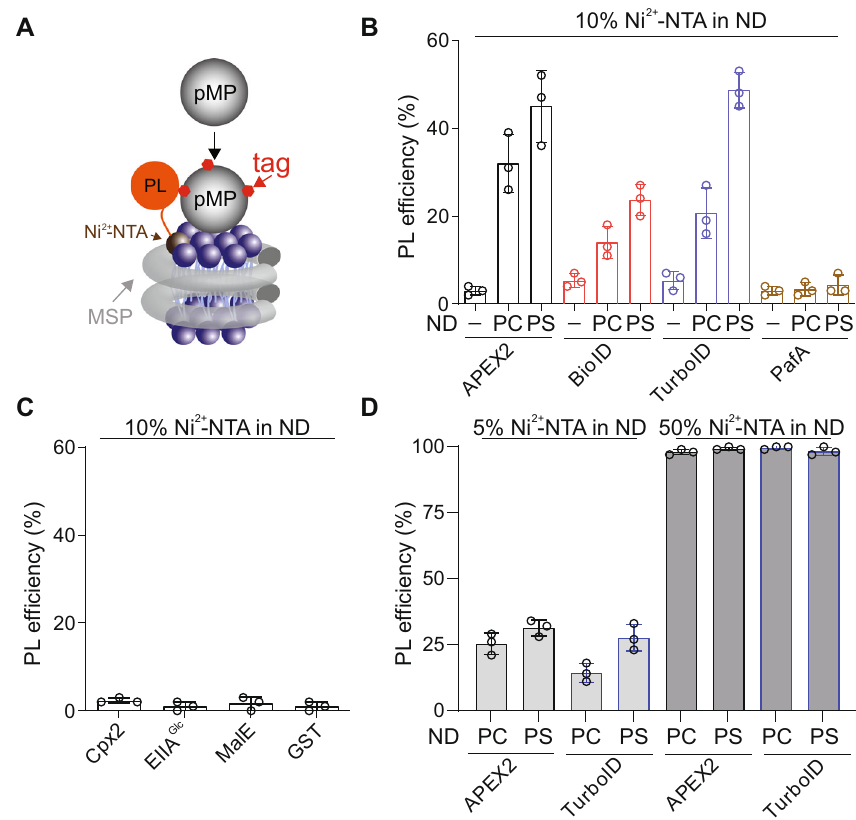
Fig. 1 Screening of PL enzymes suitable for developing nanodisc-ID. A In the initial screening, PL enzymes were attached to nanodiscs through the interaction of their N-terminal His-tag with Ni 2 + containing lipid bilayers. B Quanti fi cation of syt1 labeling ef fi ciency by the indicated PL enzymes immobilized on the lipid bilayer of PC and PS nanodiscs containing 10% Ni 2 + -NTA functionalized lipids. C Labeling ef fi ciencies of low-af fi nity lipid-binding proteins, cpx2 and EIIA Glc , by TurboID immobilized on the lipid bilayer of nanodiscs. Maltose-binding protein (MalE) and Glutathione-S-transferase (GST) were used as controls. D Quanti fi cation of syt1 labeling ef fi ciency by the indicated PL enzymes immobilized on the lipid bilayer of PC and PS nanodiscs containing 5% or 50% Ni 2 + -NTA functionalized lipids. Data are shown as mean ± s.d., n = 3 independent